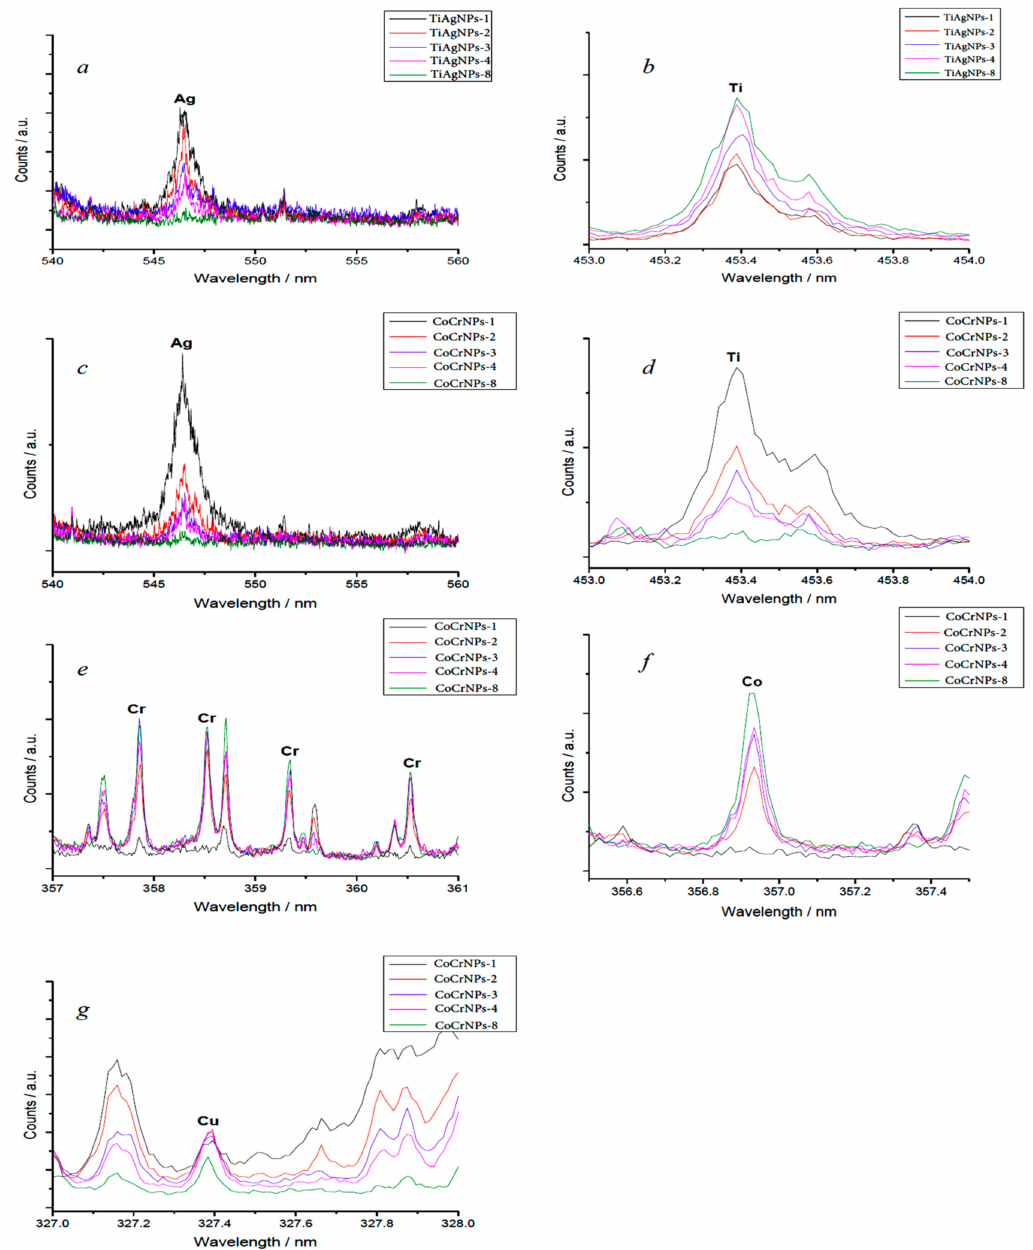
Figure 3. Insets of Laser Induced Breakdown Spectroscopy (LIBS) spectra relative to Ag ( a ) and Ti ( b ) in TiAl6V4-AgNPs coupons and Ag ( c ), Ti ( d ), Cr ( e ), Co ( f ), Cu ( g ) in CoCr-AgNPs coupons. Sample numbering indicates the progressive order by which the analysis was made by repeatedly shooting the laser on the same